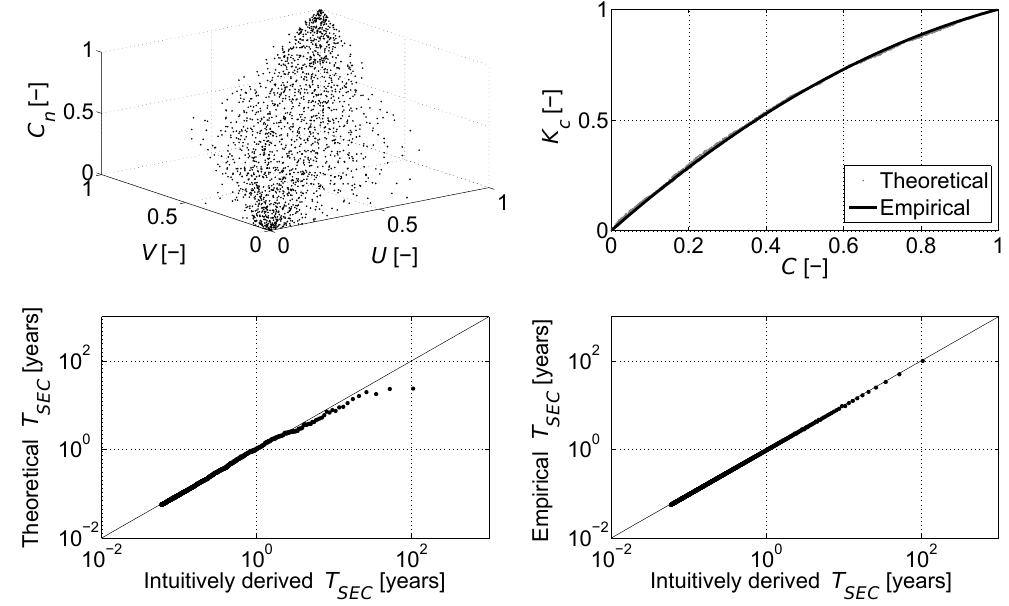
Fig. 3. Importance of a good fit for the interpretation of the secondary return period, considering the winter storms. Table 2. Kendall’s tau τ K and the estimated A12 copula parameter θ with 95% confidence bounds (lower bound LB and upper bound UB) and corresponding S n and T n goodness-of-fit measures with their p-values for the storms per